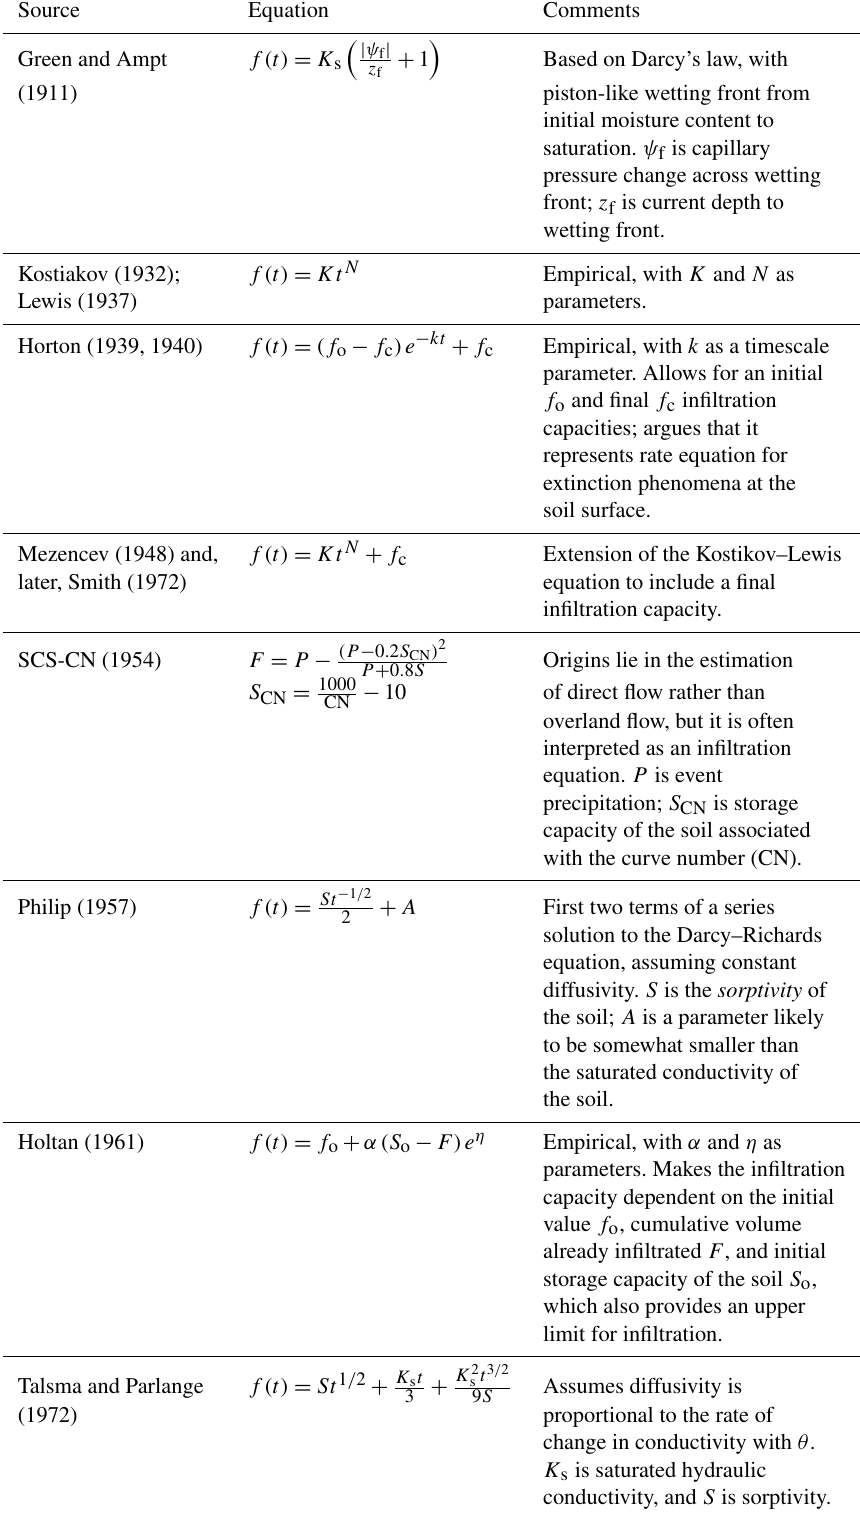
Table 1. Selected 20th century infiltration equations with f (t) as infiltration capacity, F(t) as cumulative infiltration, and K s as saturated hydraulic conductivity (other symbols defined under